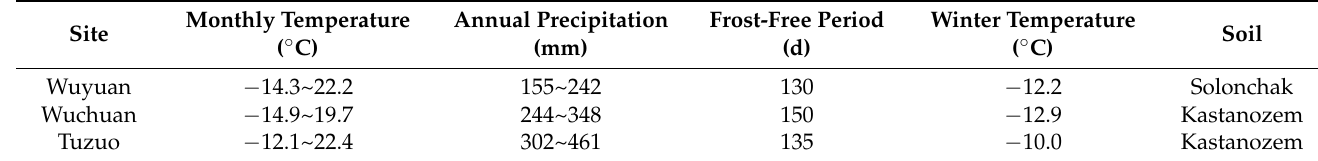
Table 1. Climatic and soil conditions of the experimental sites.